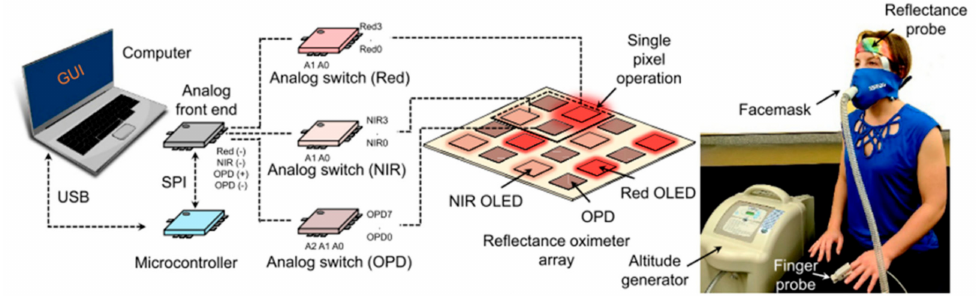
Figure 12. Design of the reflectance oximeter system, where each pixel comprising one red OLED, one near-infrared (NIR) OLED and two OPDs, is connected to an instrumet for driving the devices ( left panel). Analog switches, Arduino microcontroller and universal serial bus (USB) connection are used. Setup of an altitude simulator that modifies the oxygen content of the air is showed during the operation on a volunteer breathing via a facemask ( right panel). © 2020 by Proceedings of the National Academy of Sciences (PNAS), adapted with permission from